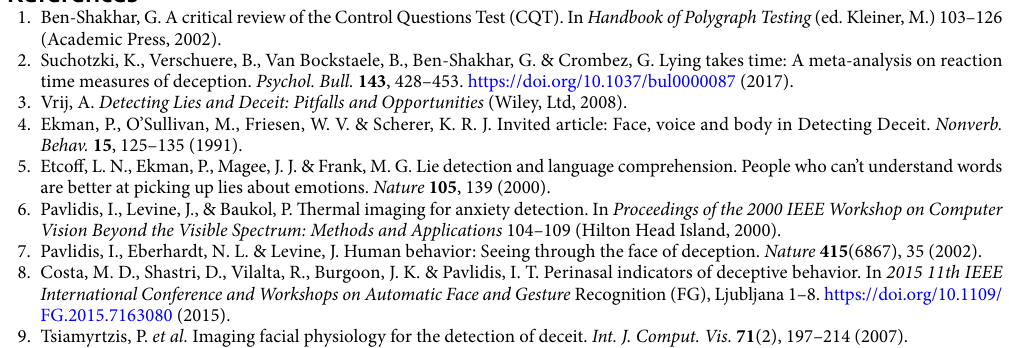
as possible to the left stimulus by pressing the right response key and to the right stimulus by pressing the left response key (left and right buttons were the same used in the first and the third session), see Fig. 2, middle panel a. In the Training session of condition 2, participants were required to perform a spatial compatibility task with a compatible S–R mapping. They were instructed to respond as quickly and accurately as possible to the left stimulus by pressing the left response key and to the right stimulus by pressing the right response key (see Fig. 2, middle panel b). In the Training session of condition 3, half of participants were instructed to respond as quickly and accurately as possible to the blue stimulus by pressing the right response key and to the red stimu- lus by pressing the left response key (see Fig. 2, middle panel c), while the other half experienced the opposite mapping rule. In condition 4, the Training session was not present. Participants waited 5 min without doing any kind of task and then started the Test session (see Fig. 2, middle panel d). In the Training session of the first three conditions, the trial started with a fixation presented at the center of the screen for 1000 ms. Subsequently, the stimulus appeared and remained on the screen until a response was provided. The Training session consisted of 150 experimental trials that were divided into three blocks of 50 trials each and preceded by 10 trials of practice.